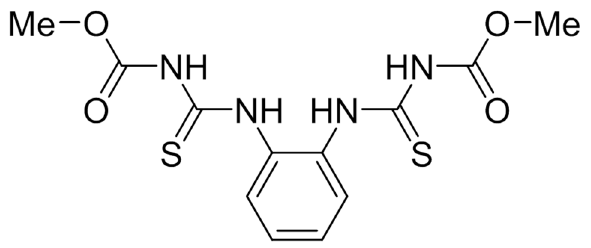
Figure 1. The chemical structure of thiophanate methyl.